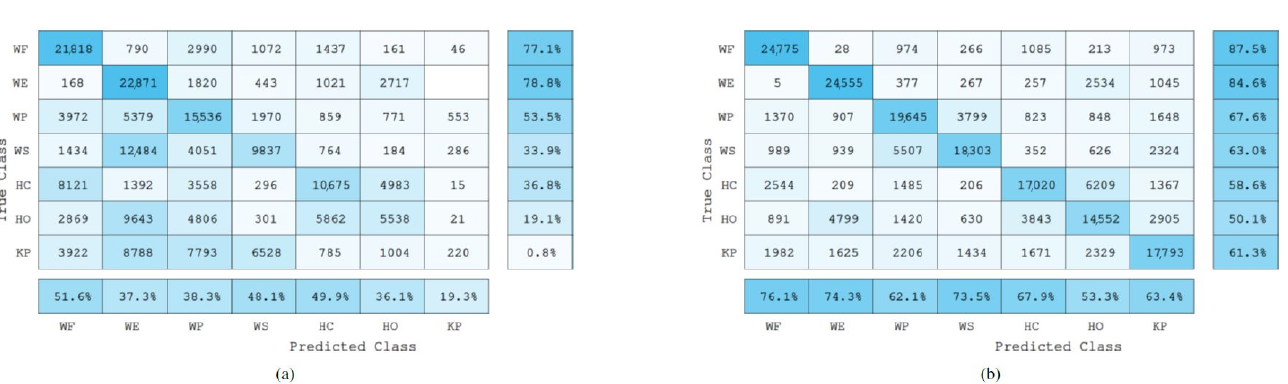
Figure 10. Adaptive LS-SVM confusion matrices of the seven gestures collected using EMG data only ( a ), and EMG and IMU data ( b ) from all testing subjects. The numbers inside each cell represent the number of sample points classified. The last row from each confusion matrix represents the precision score percentages of each class. Similarly, the last column represents the recall score percentages of each class.